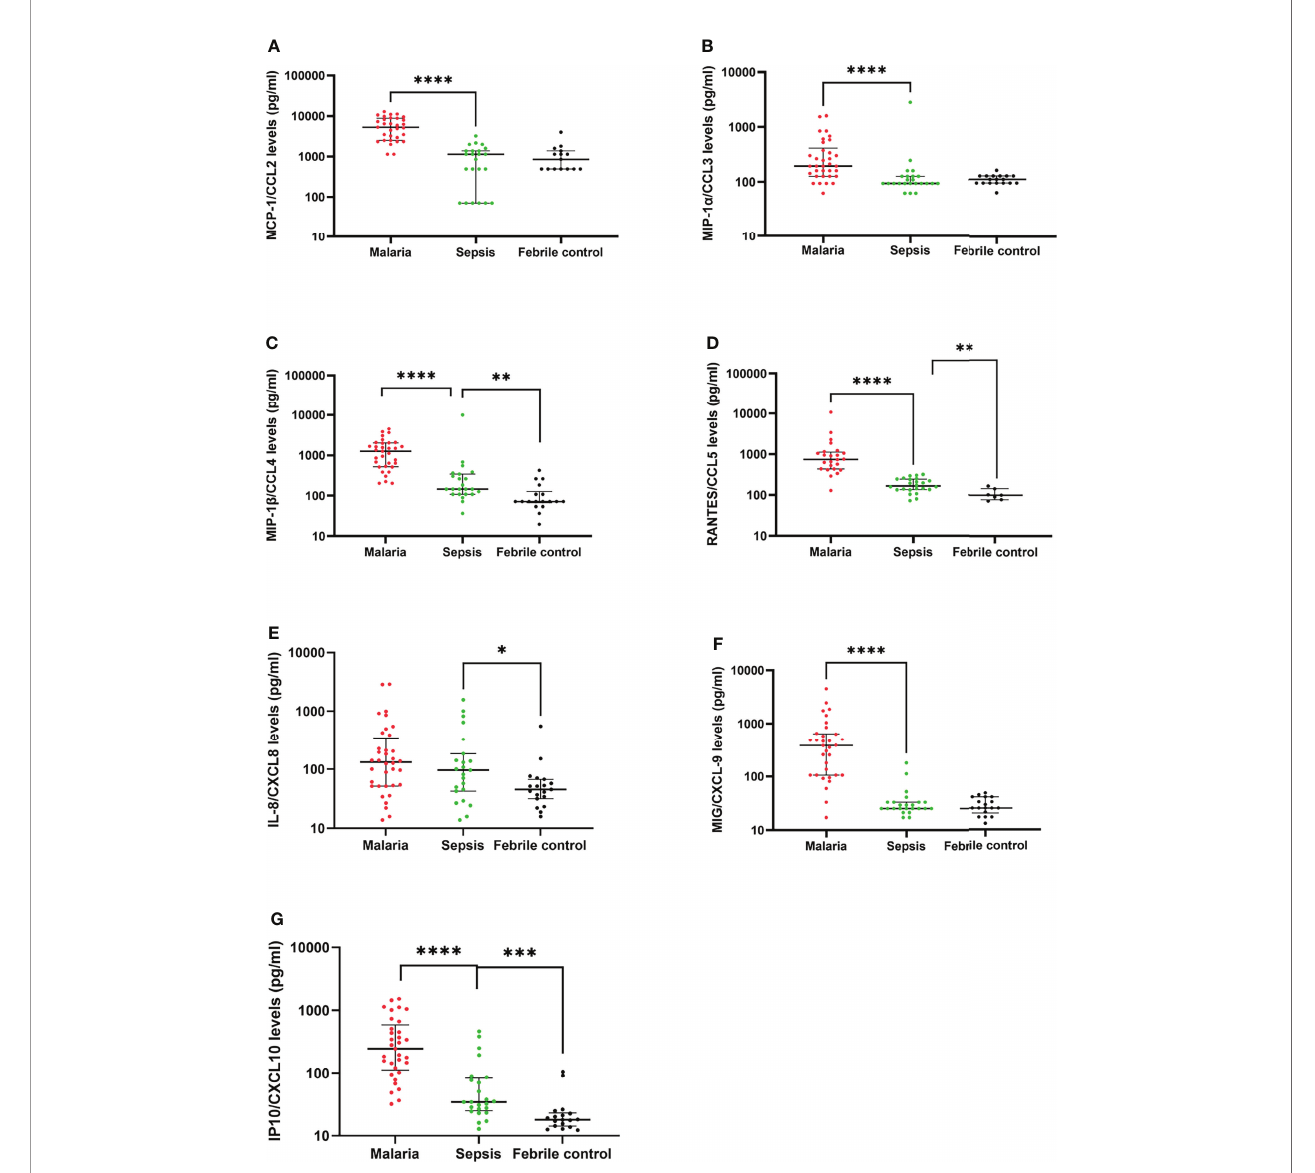
FIGURE 1 | Patterns of chemokine expression in children with sepsis compared to malaria and febrile controls. The scatter plots show the plasma levels of chemokines (pg/ml) (A-G) detected in children with clinical malaria, sepsis and febrile controls. The plots indicate the median and interquartile ranges. Differences were considered signi fi cant when p<0.05. Statistically signi fi cant values are denoted by *p < 0.05; **p < 0.01; ***p < 0.001; ****p < 0.0001. Statistical analyses were performed using the Kruskal-Wallis with Dunn ’ s Multiple comparison post-hoc